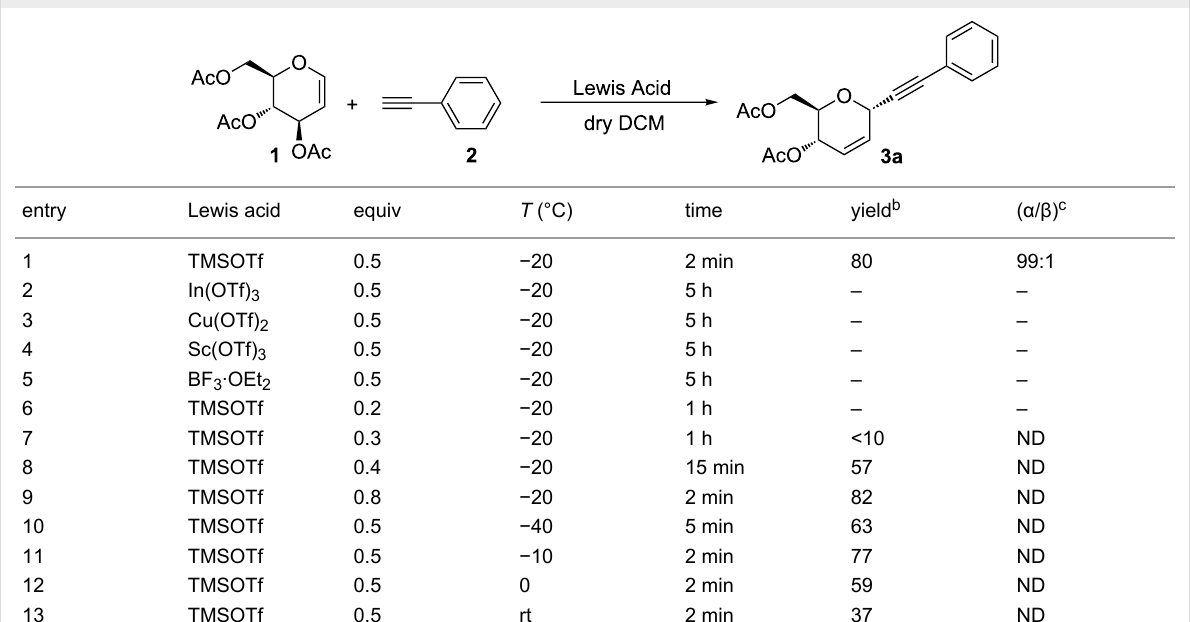
Table 1: Alkynylation reaction of 3,4,6-tri- O -acetyl-D-glucal with phenylacetylene a